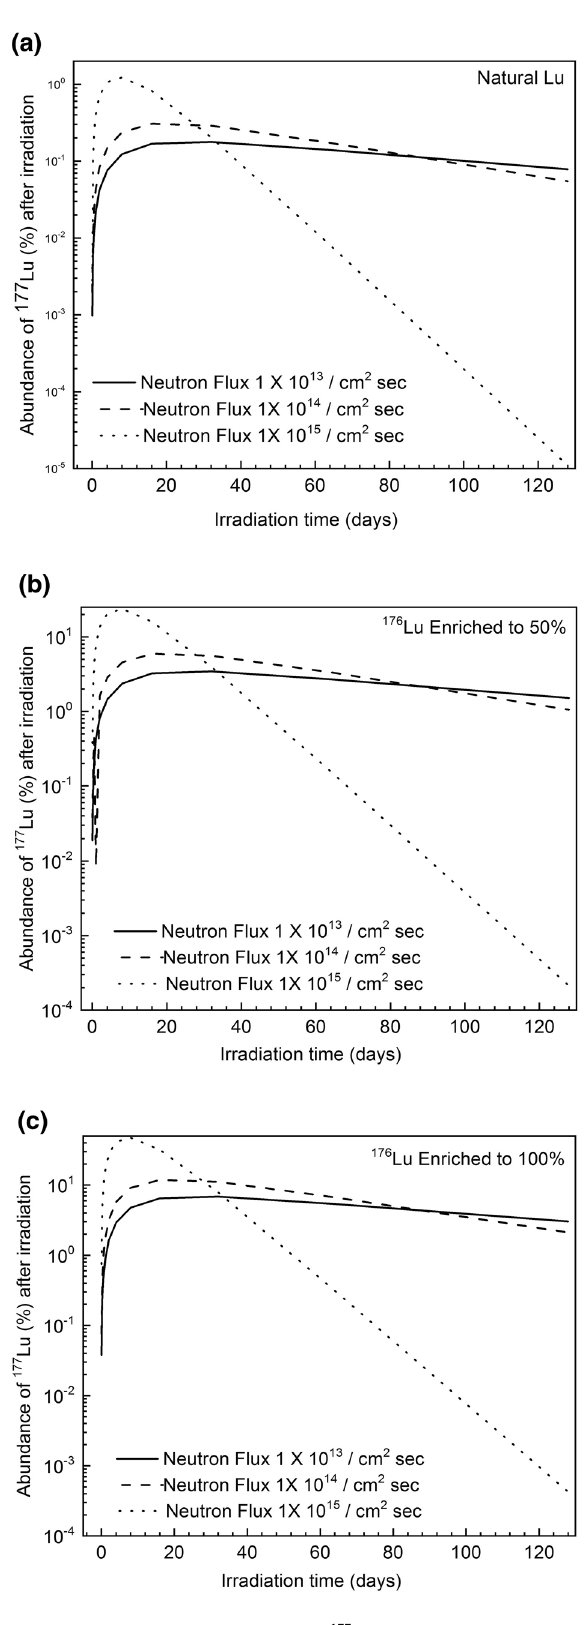
Figure 1. Percentage abundance of 177 Lu after irradiation in a reactor with different nuclear fluxes for the cases of ( a ) natural Lu, ( b ) 50% enriched 176 Lu and ( c ) 100% enriched 176